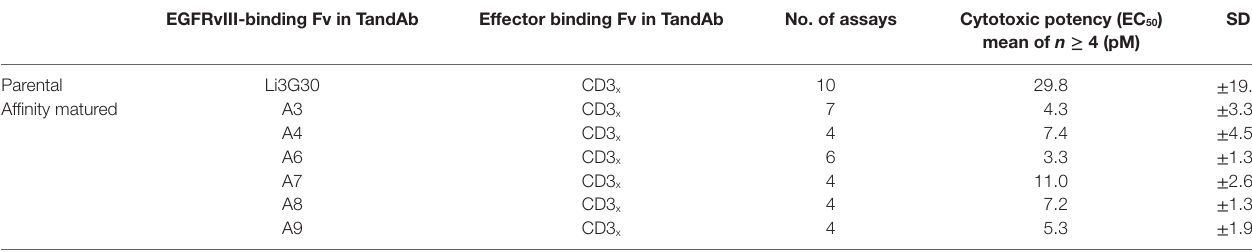
sD mean of n ≥ 4 (pM)